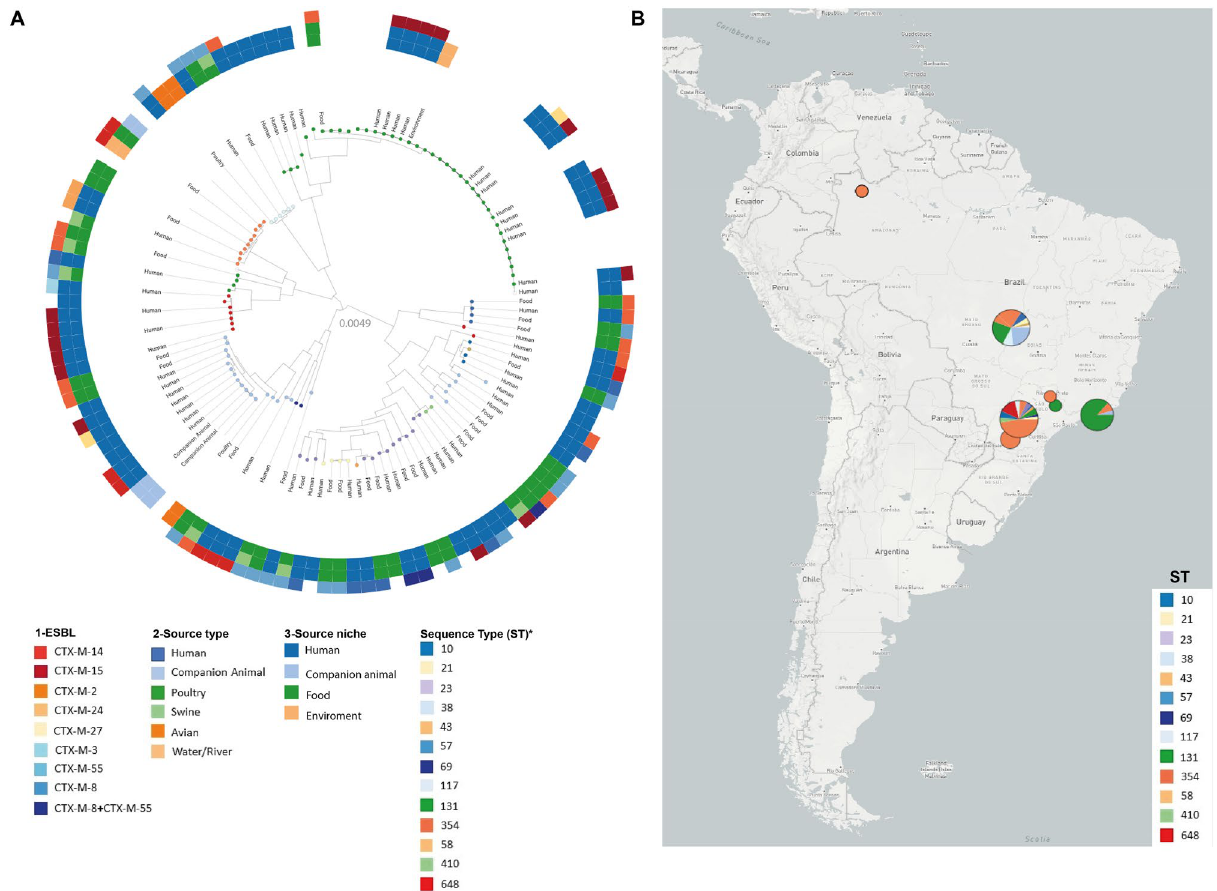
Figure 1. ( A ) Escherichia coli Phylogenomic SNP tree with circular heatmap shows (outside-in reading rings): ESBL-gene (first inner ring); source type (second inner circle) and source niches (third inner circle). ( B ) Distribution map of Escherichia coli sequence type (ST) in Brazilian regions. Asterisk: bubbles colors in phylogenomic